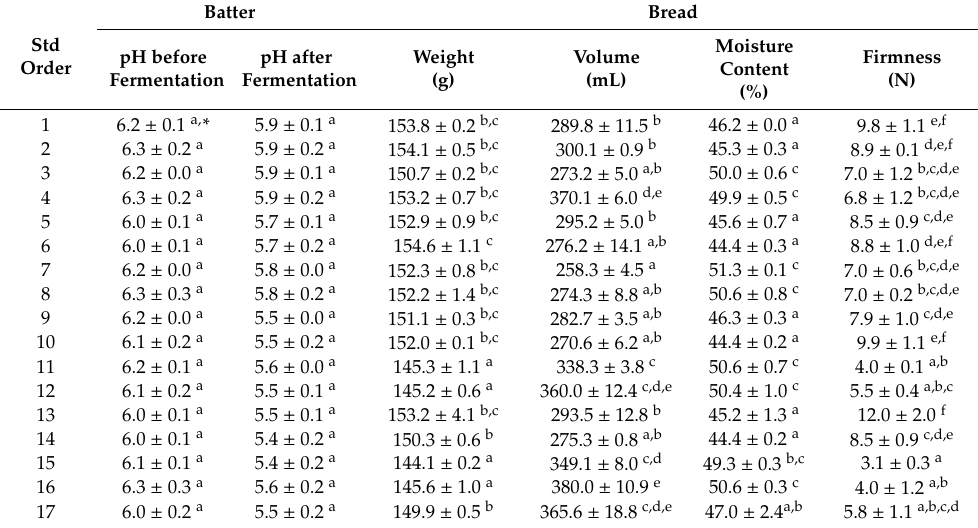
Table 2. pH of batter before and after fermentation and gluten-free rice bread characteristics tested by a full factorial design.